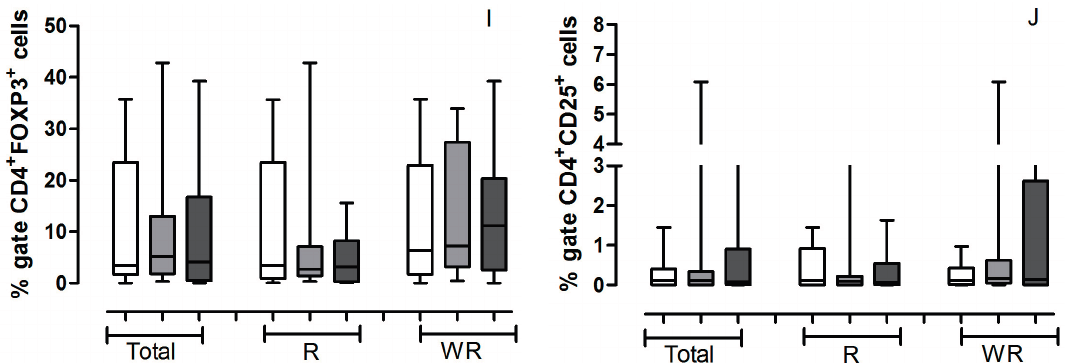
Figure 1. Values (median) of % gate of helper T lymhocytes positive for cytokines obtained from all the patients studied. The gate was determined for localization of cells corresponding to lymphocytes by relative size (Forward Scatter, FSC) and granularity/complexity